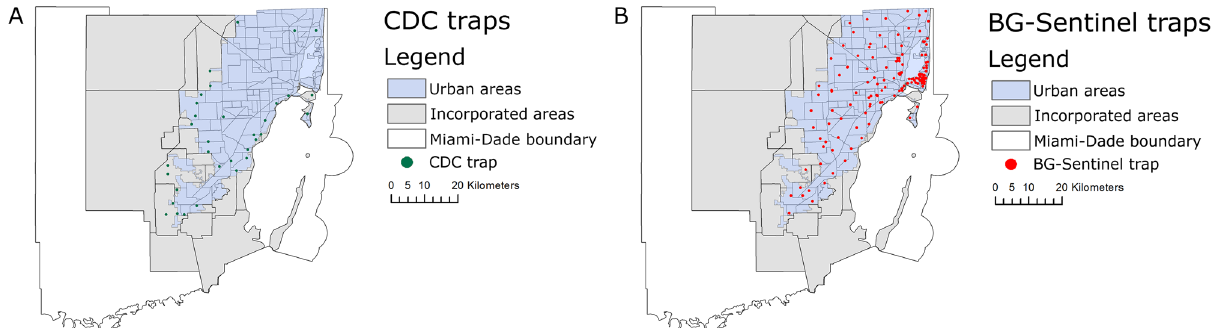
Figure 4. Map of Miami-Dade County, Florida. ( A ) Location of the 32 CDC traps; and ( B ) location of the 150 BG-Sentinel traps. The figure was produced using ArcGIS 10.2 (Esri, Redlands, CA), using freely available